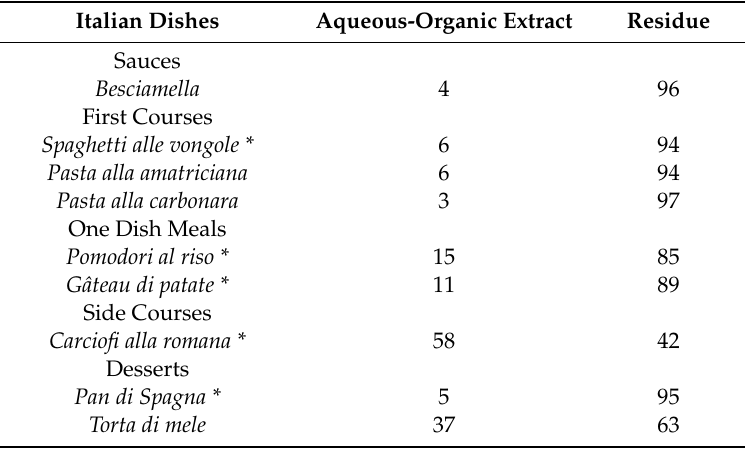
Table 2. Contribution % of extractable and non-extractable compounds to antioxidant properties of popular Italian dishes *. Italian Dishes Residue Sauces